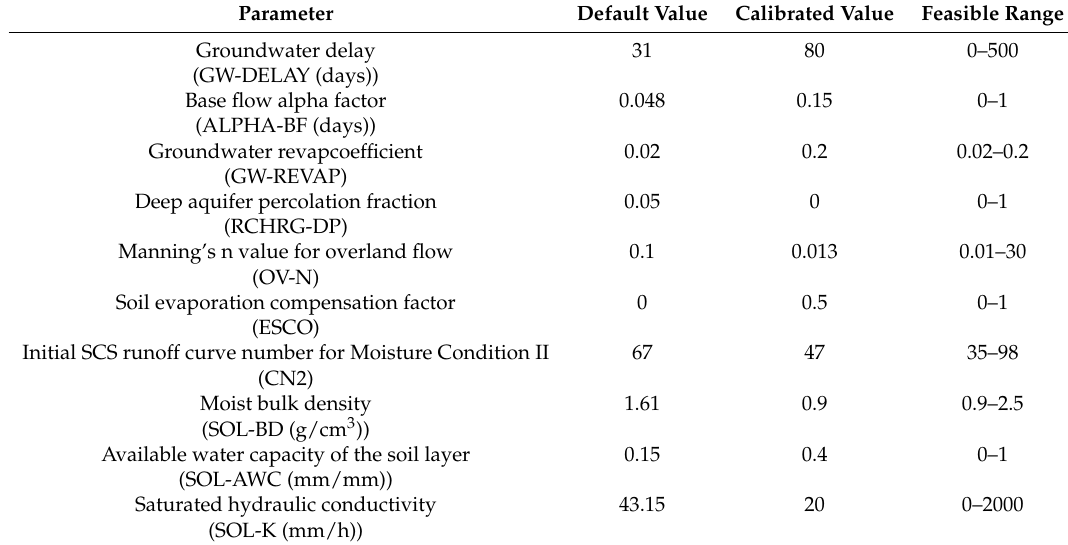
Table 4. Calibrated parameter